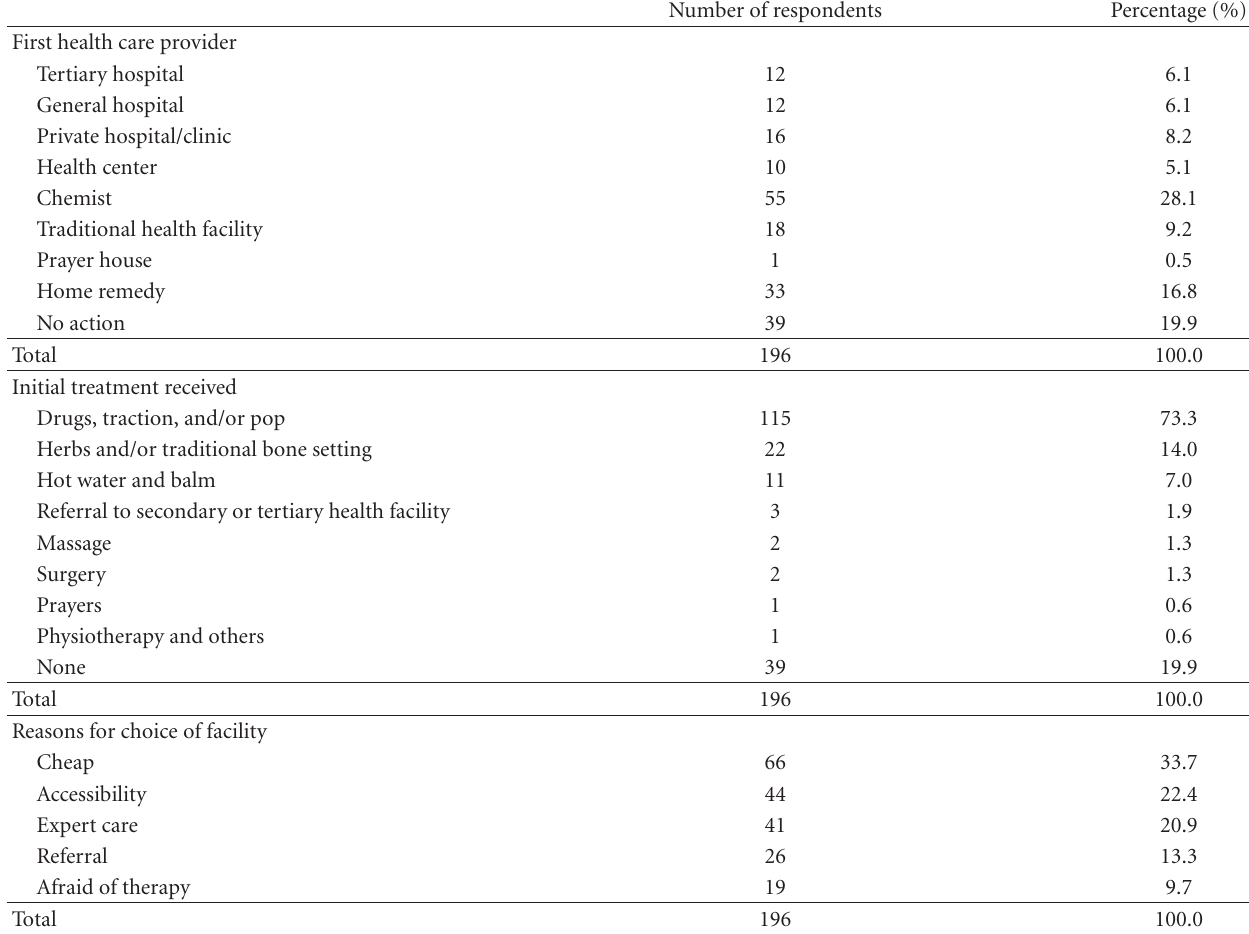
Table 3: Management of movement/functional problems at household